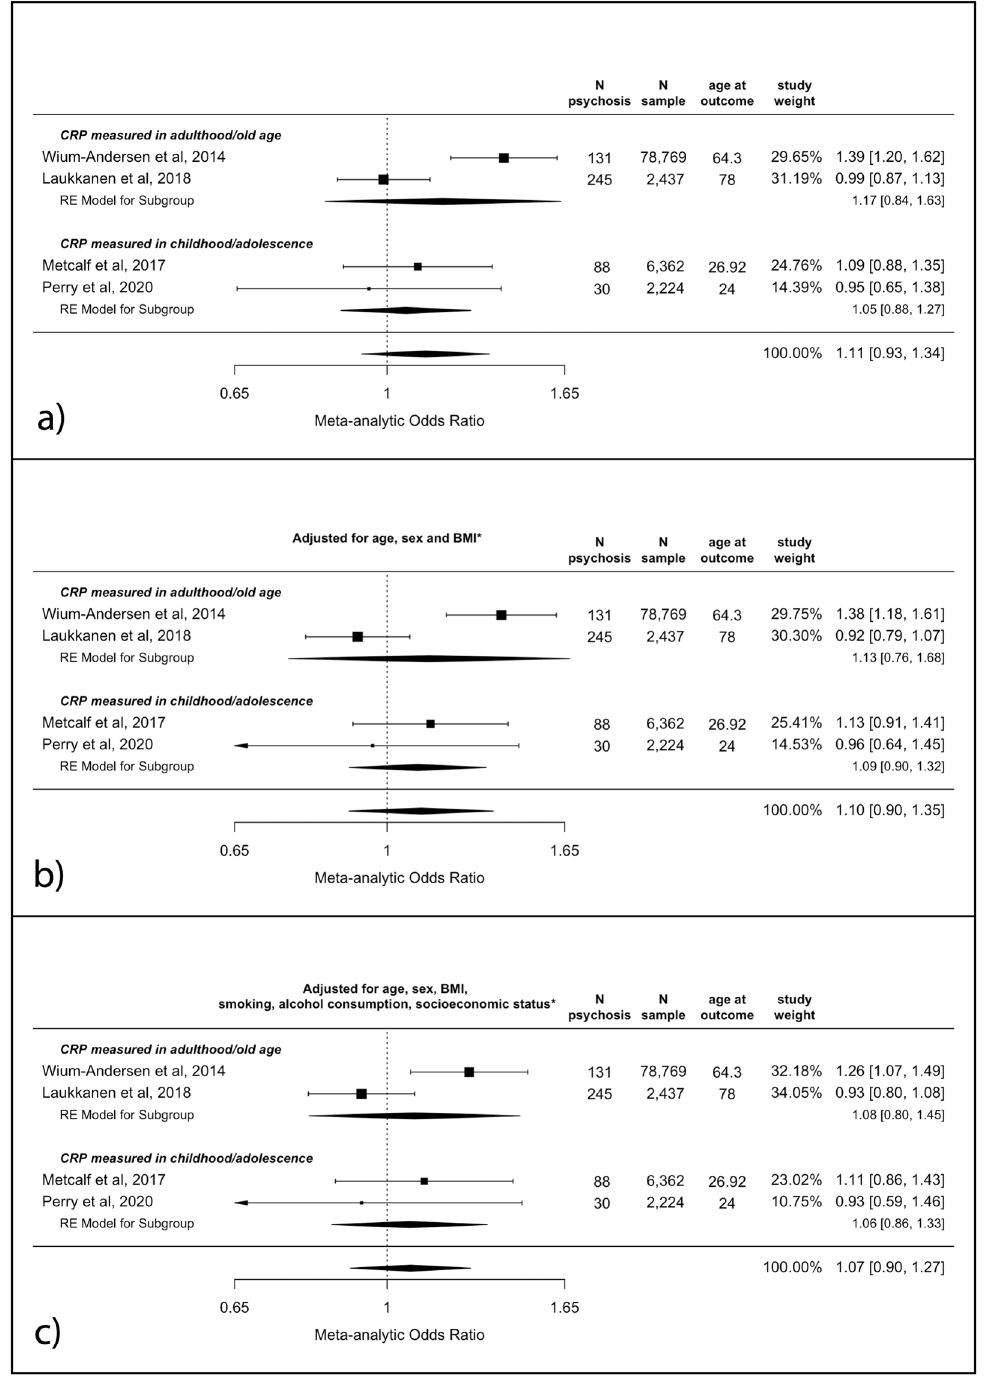
Fig. 2 Odds ratios for psychosis at follow-up per SD increase in CRP levels at baseline. a Unadjusted analysis; b adjusted for age, sex and BMI; c adjusted for age, sex, BMI, smoking, alcohol consumption and socioeconomic status. * see “ Methods ” for speci fi c covariates used for each study. BMI body mass index, CRP C-reactive protein, SD standard